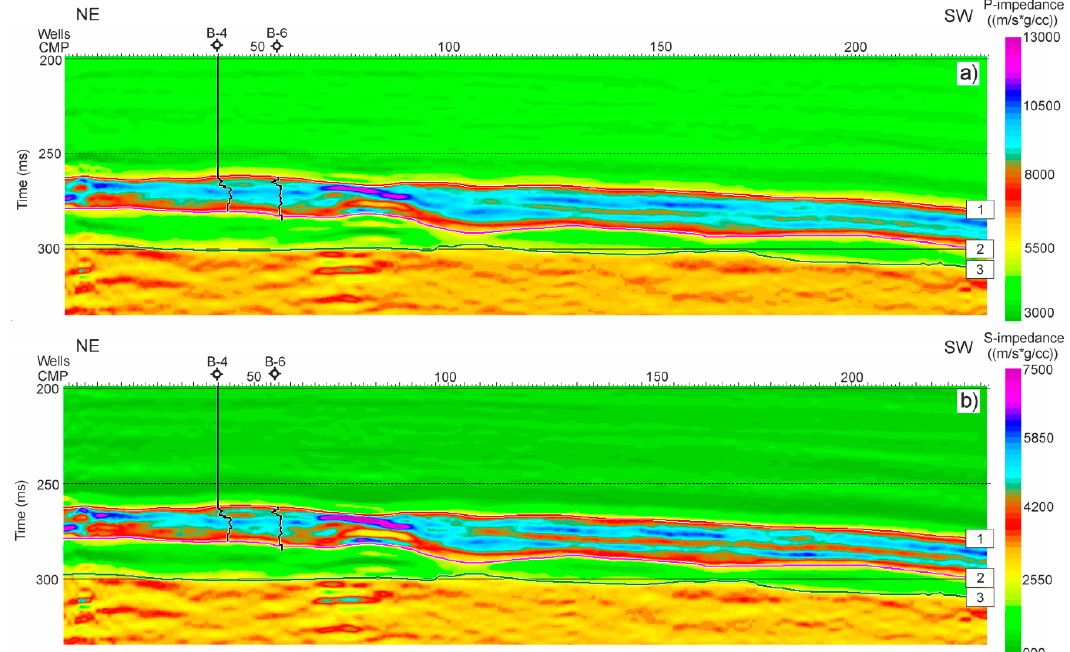
Figure 11. Part of profile 2 showing the zone of interest as: ( a ) P-wave impedance, ( b ) S-wave impedance. Well logs indicate sulfur content (%). Well B-6 is projected into the profile with 25 meters offset. As can be seen, both impedances give a similar image of sulfur deposit. Horizons 1 and 2 are, respectively, the top and bottom of the evaporitic formation; horizon 3 is the top of the Cretaceous